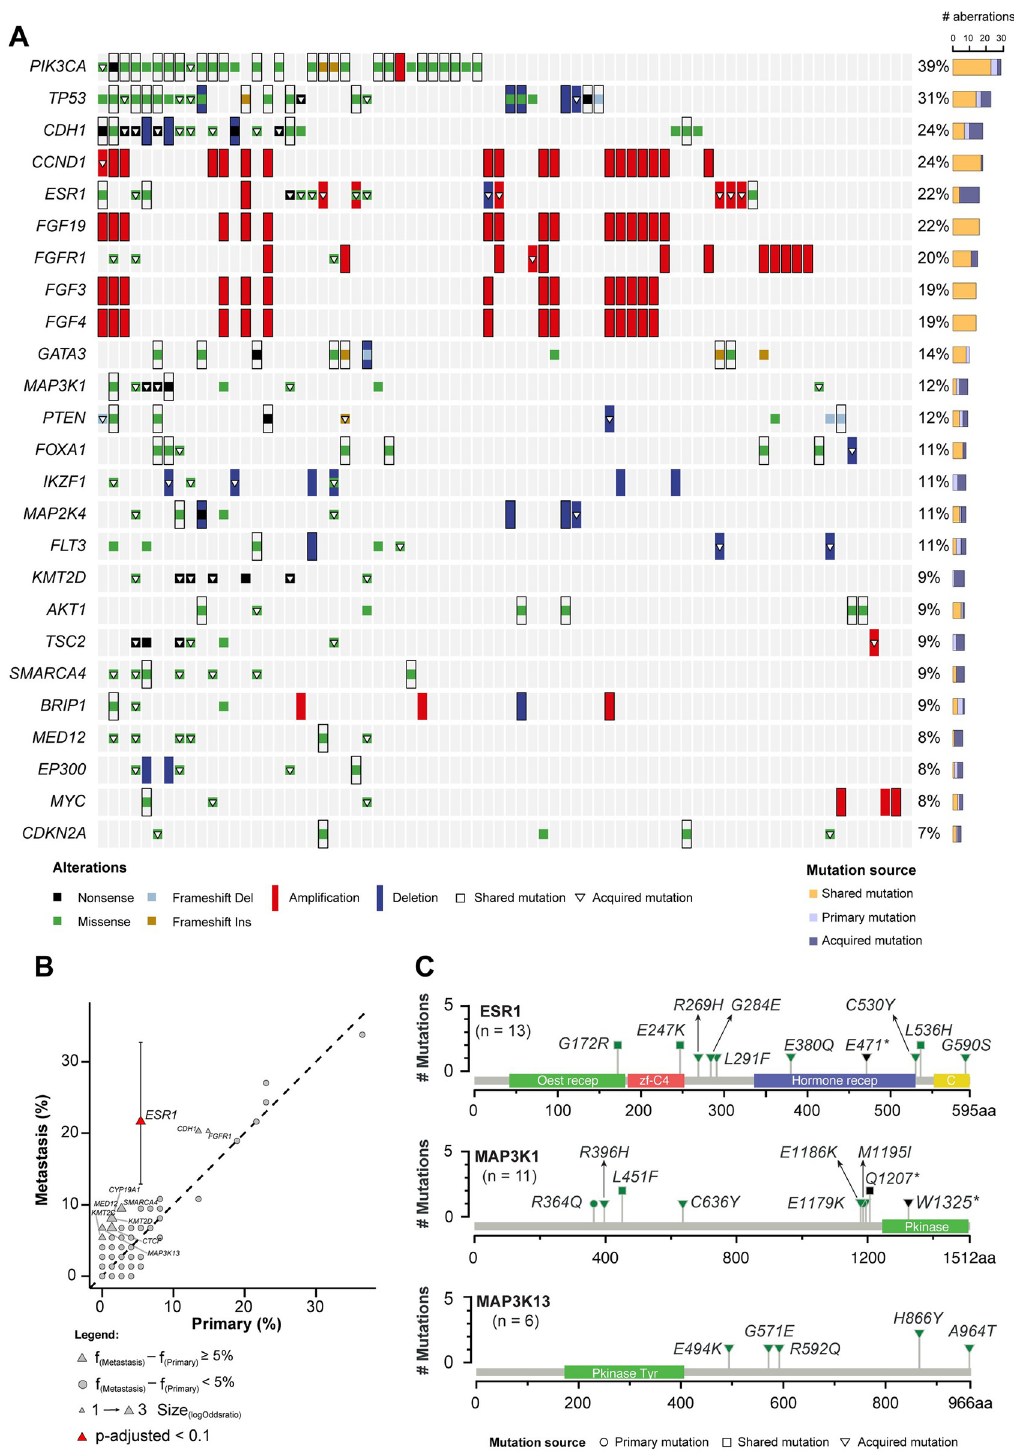
Fig 1. Repertoire of genomic alterations in primary and metastatic HR+ HER2- breast cancer (BC). A) Recurrent driver somatic mutations and copy number variations identified in matched primary and metastatic HR+ HER2- BC specimens (n = 74) subjected to targeted sequencing (n = 148). Cases are shown in columns, whereas genes are shown in rows. Mutation types are color-coded according to the legend. The total number of alterations detected in individual genes is displayed on the bar plot (right). For graphical purpose, only the top 25 genes are shown. B) The scatter plot reports the mutational